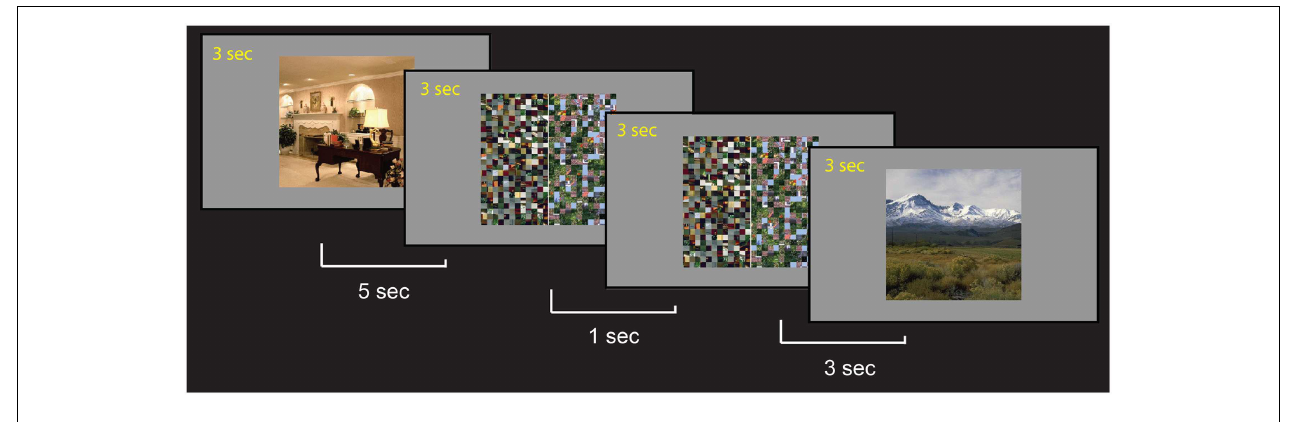
scene was an indoor or outdoor picture. For the control scrambled picture trials, participants were asked to indicate if the patterns on the two sides